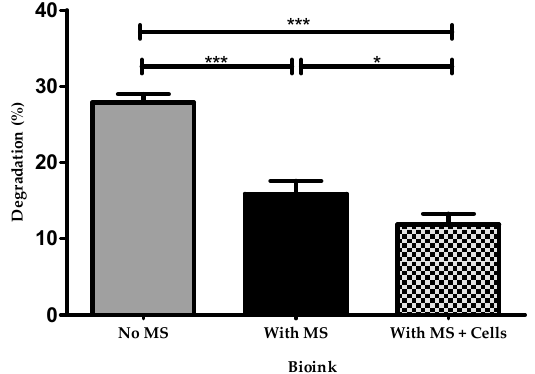
Figure 13. Biodegradation rate of bioprinted construct with cells and microspheres, with micro- spheres, and without microspheres. *** and * indicates statistical differences between the three different groups.